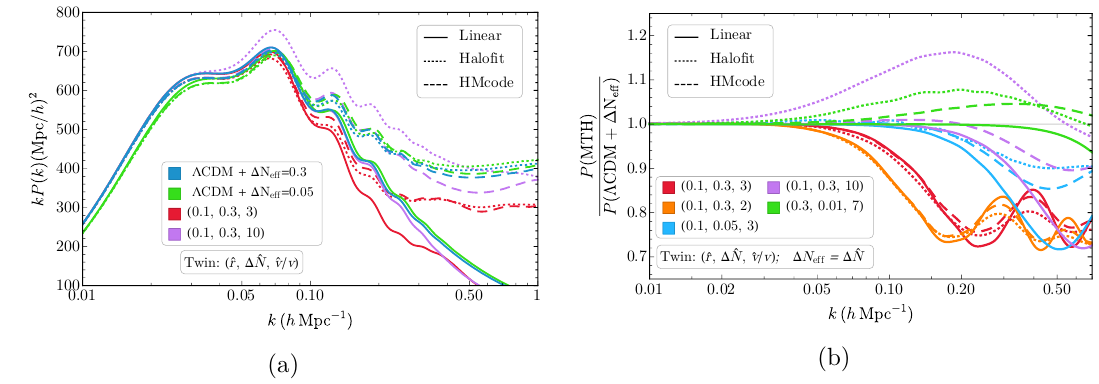
Figure 16. Non-linear corrections to the matter power spectrum computed using Halofit and HM-